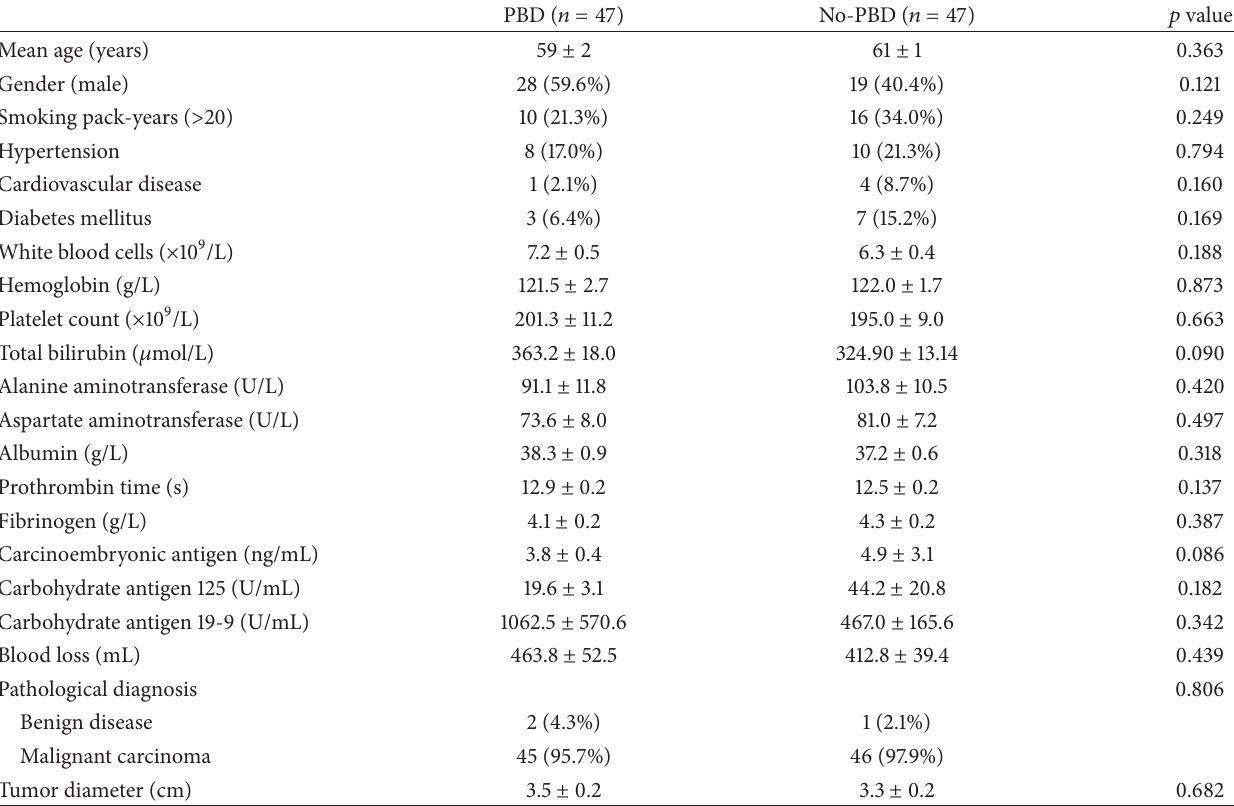
Table 4: Clinical characteristics of 94 matched patients.